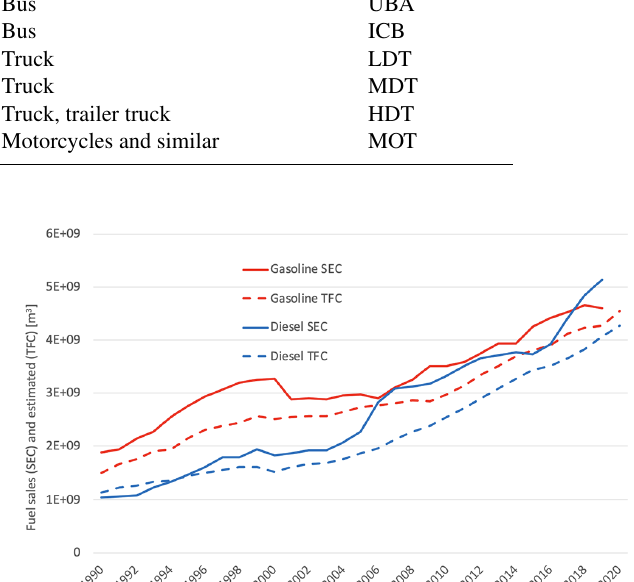
Figure 2. National fuel sales and estimated total fuel consumption for gasoline and diesel in